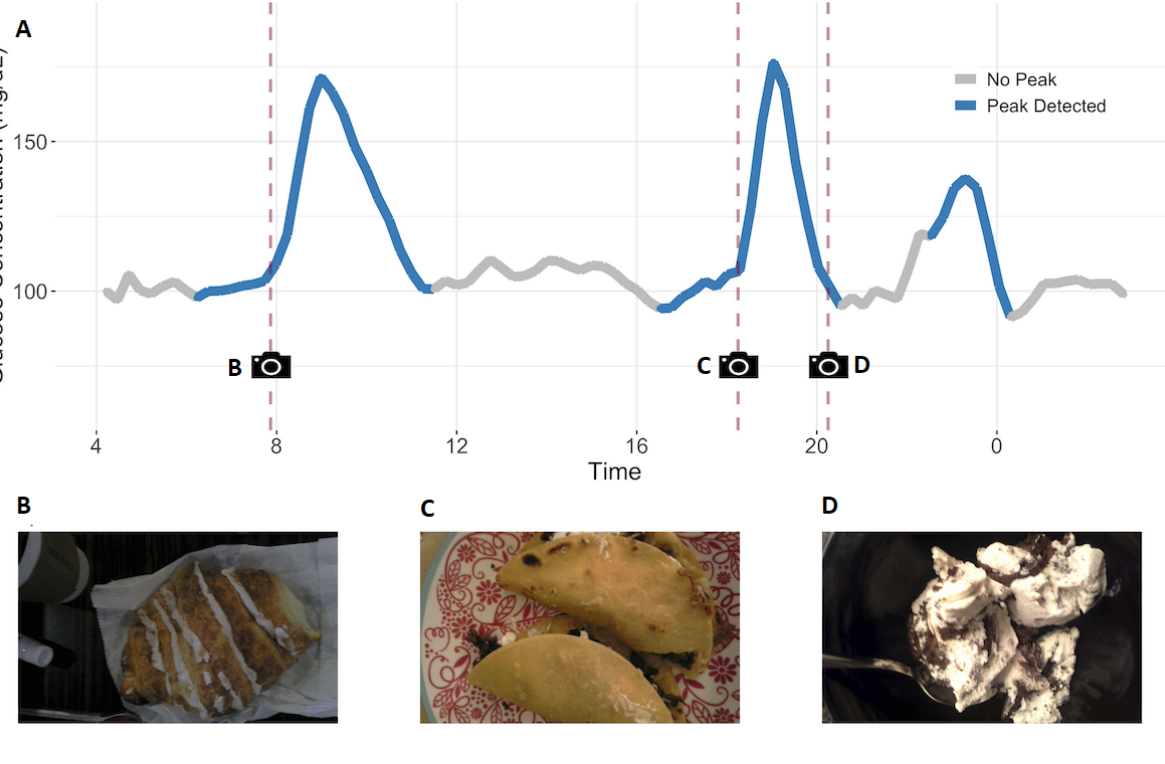
Figure 4. Continuous glucose monitoring (CGM) devices capture more data than the standard meal-tolerance test. (A) Zooming on a specific day allows one to display an entire day of glucose estimates (March 20, 2018, for Subject 1). Peaks are detected with the in-house algorithm (Multimedia Appendix 1) and colored in blue. Annotations logged in the smartphone app by the subject are marked with a dashed red vertical line and a picture logo. (B-D) Pictures submitted by Subject 1 through the app on March 20,